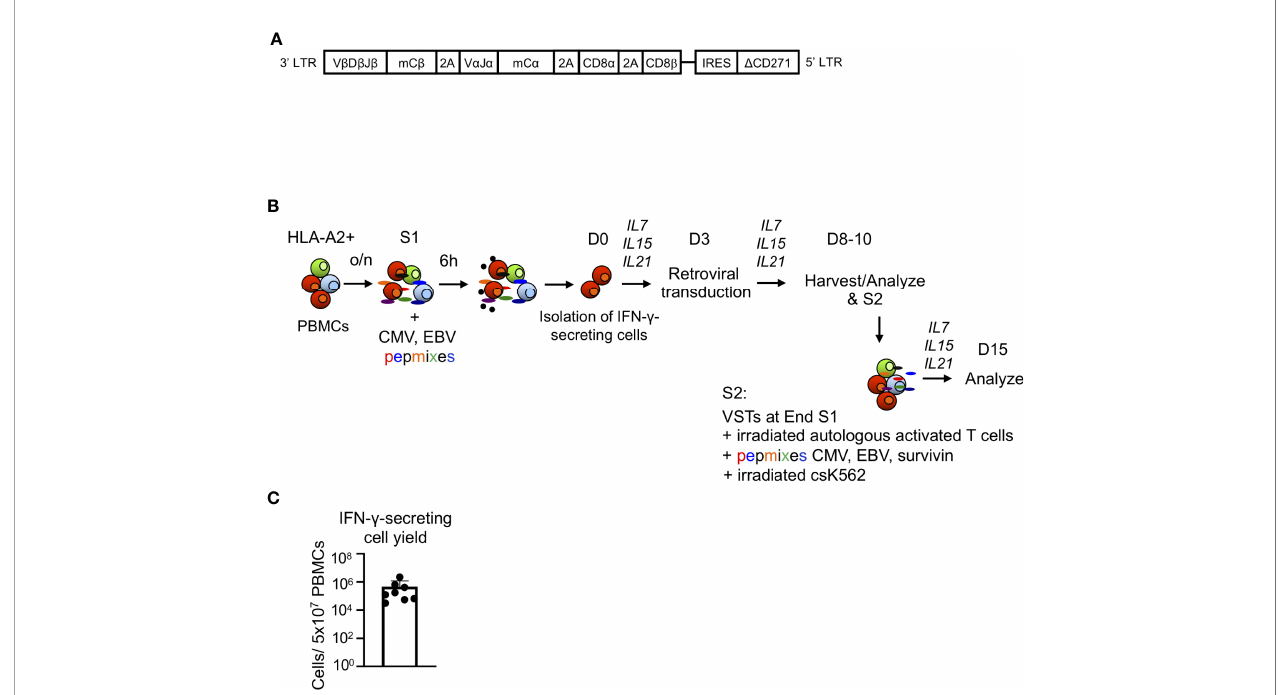
FIGURE 1 | Generation of TCR8 transgenic VSTs by IFN- g cytokine capture and retroviral transduction. (A) Schematic of the retroviral vector containing the survivin- speci fi c TCR with murine constant regions (mC a , mC b ), CD8 ab and a truncated selectable marker ( D CD271). (B) Steps involved in the production of transgenic VSTs using IFN- g CC, retroviral transduction and cell expansion. S1: fi rst stimulation, S2: second stimulation (optional). (C) Total yield of IFN- g captured cells from 5x10 7 PBMCs after immunomagnetic separation, n=8 donors, mean ±